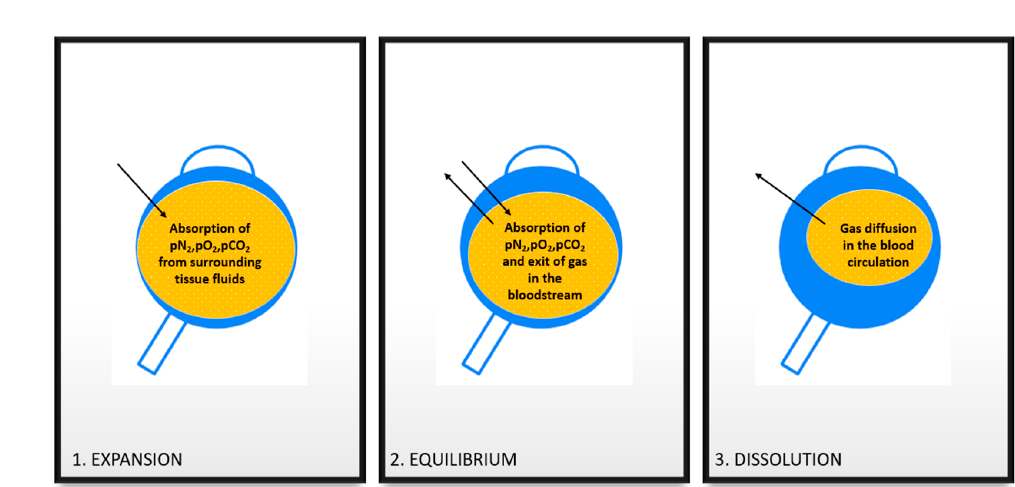
Figure 4. Schematic of the three phases of a gas bubble injected into the vitreous cavity. ( 1 ) Expansion, occurring 6–8 h postoperatively with a net acquisition of pN 2 , pO 2 , and pCO 2 into the gas tamponade bubble from the surrounding tissue fluids. ( 2 ) Equilibrium, occurring in the following days according to the gas type, where the absorption of the above-mentioned molecules is compensated by the slippage of gas into the blood circulation. ( 3 ) Dissolution corresponds to the permanence time of gas into the eye when the volume of the gas bubble shrinks until it is completely absorbed into the blood circulation.